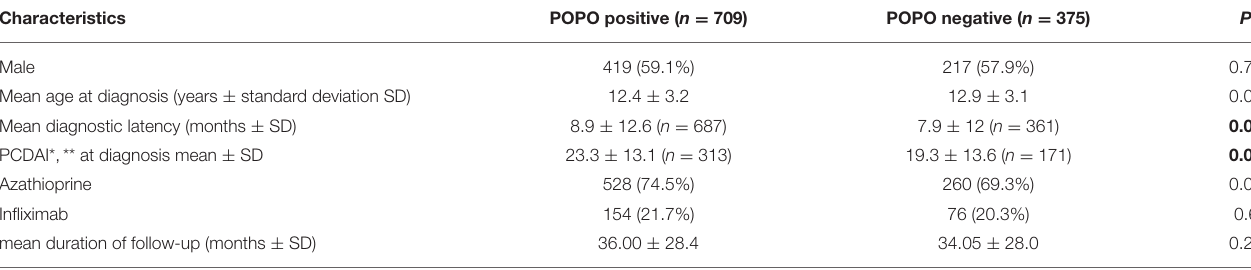
TABLE 2 | Characteristics of POPO * -positive and POPO-negative patient groups.